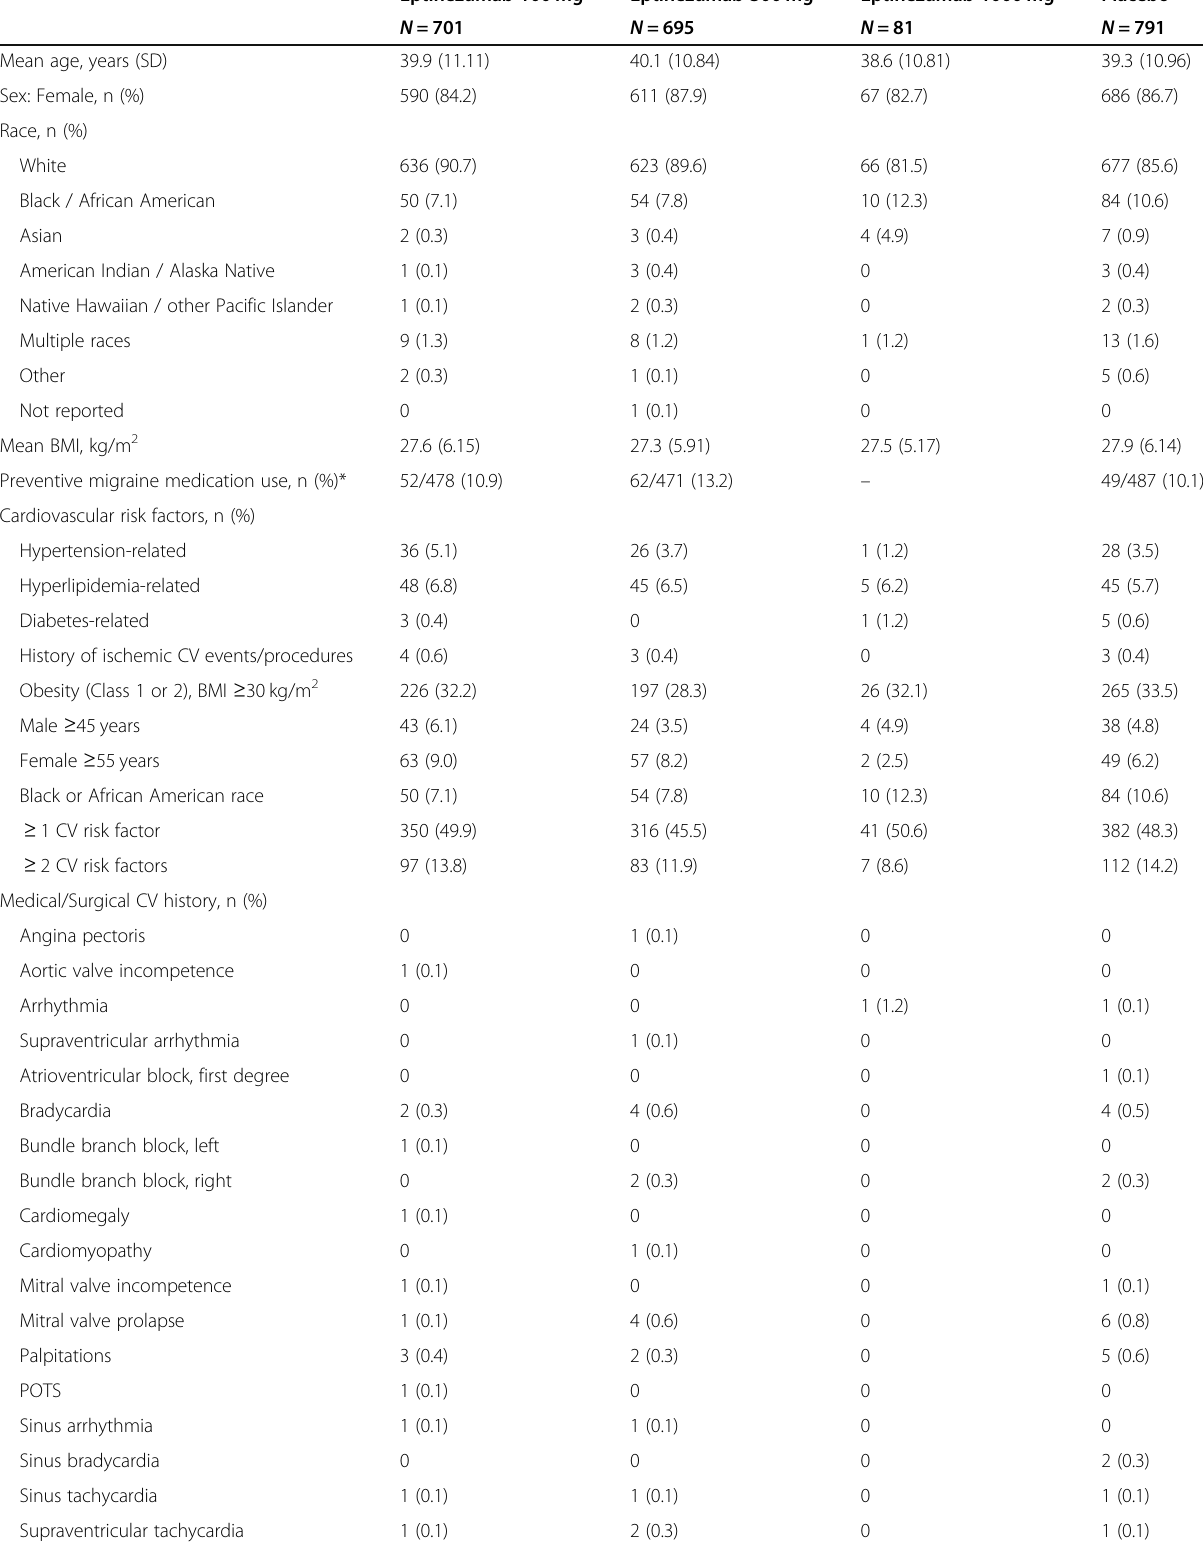
Table 2 Baseline Demographics and